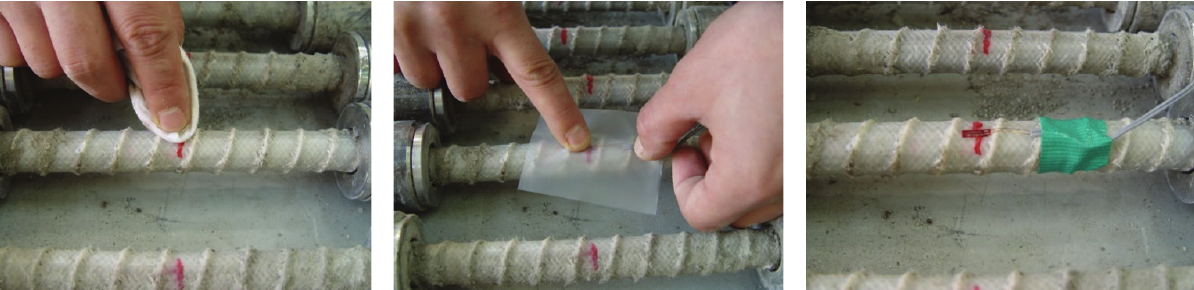
Figure 8: The strain gauge attachment.